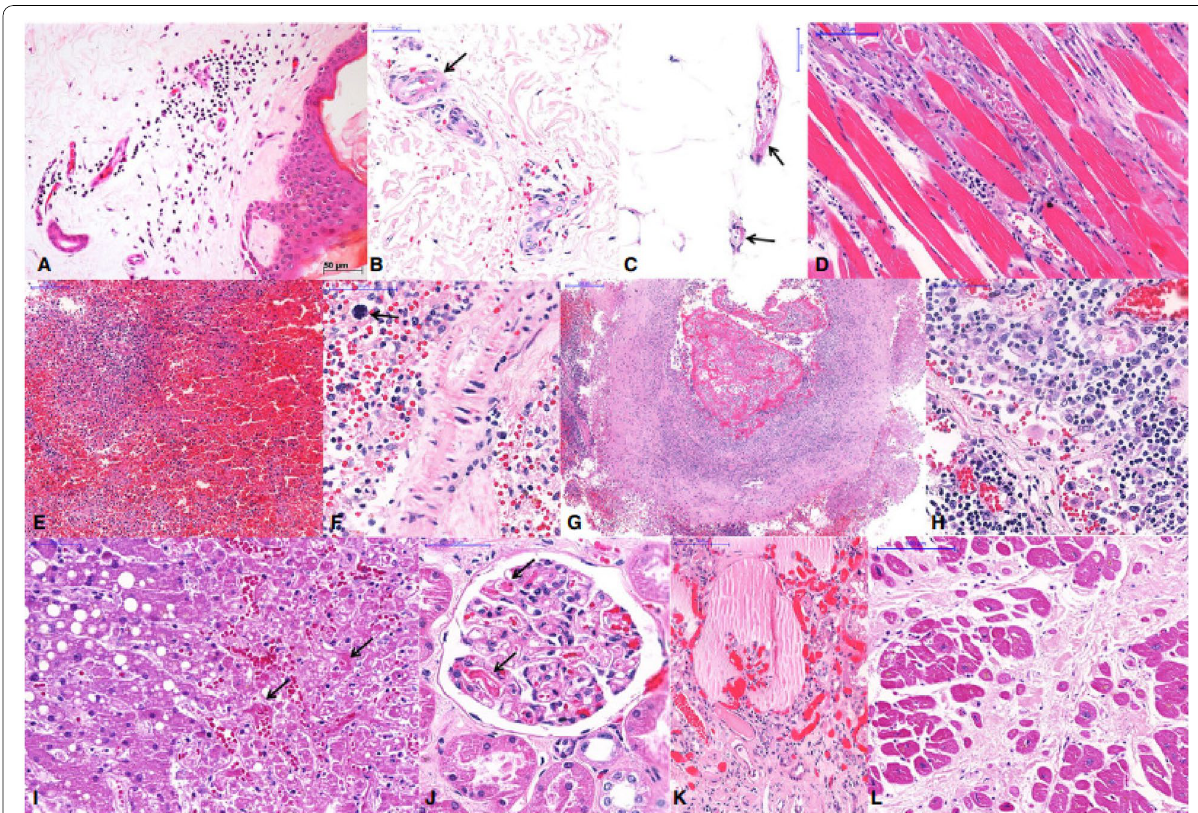
Fig. 5 Extrapulmonary histological features of 10 fatal cases of coronavirus disease 19 (COVID-19), autopsied by the use of ultrasound-guided minimally invasive autopsy. A – C Skin collected with a punch needle, showing a perivascular mononuclear infiltrate at the superficial dermis ( A ), purpura ( B ), and fibrinoid alteration in small vessels of the dermis ( B ) and hypodermis ( C ). D Thoracic skeletal muscle with myositis and myolisis. E – G Spleen showing red pulp haemorrhage and lymphoid hypoplasia ( E ), splenitis and extramedullary haematopoiesis ( F , arrow), and thrombosis and vasculitis in a large artery ( G ). H A thoracic lymph node with hyperplasia of sinusoidal histocytes, haemophagocytosis, and activated lymphocytes. I Liver with macrovesicular steatosis, coagulative necrosis in the central area, and sinusoidal congestion with fibrin thrombi (arrows). J , K Kidney with fibrin thrombi in the capillary tuft ( J , arrows), and a collapsed tuft and interstitial fibrosis ( K ). L Heart with hypertrophy of cardiomyocytes and extensive myocardial fibrosis (previous infarction). Note: Source of figure from Duarte-Neto et al.